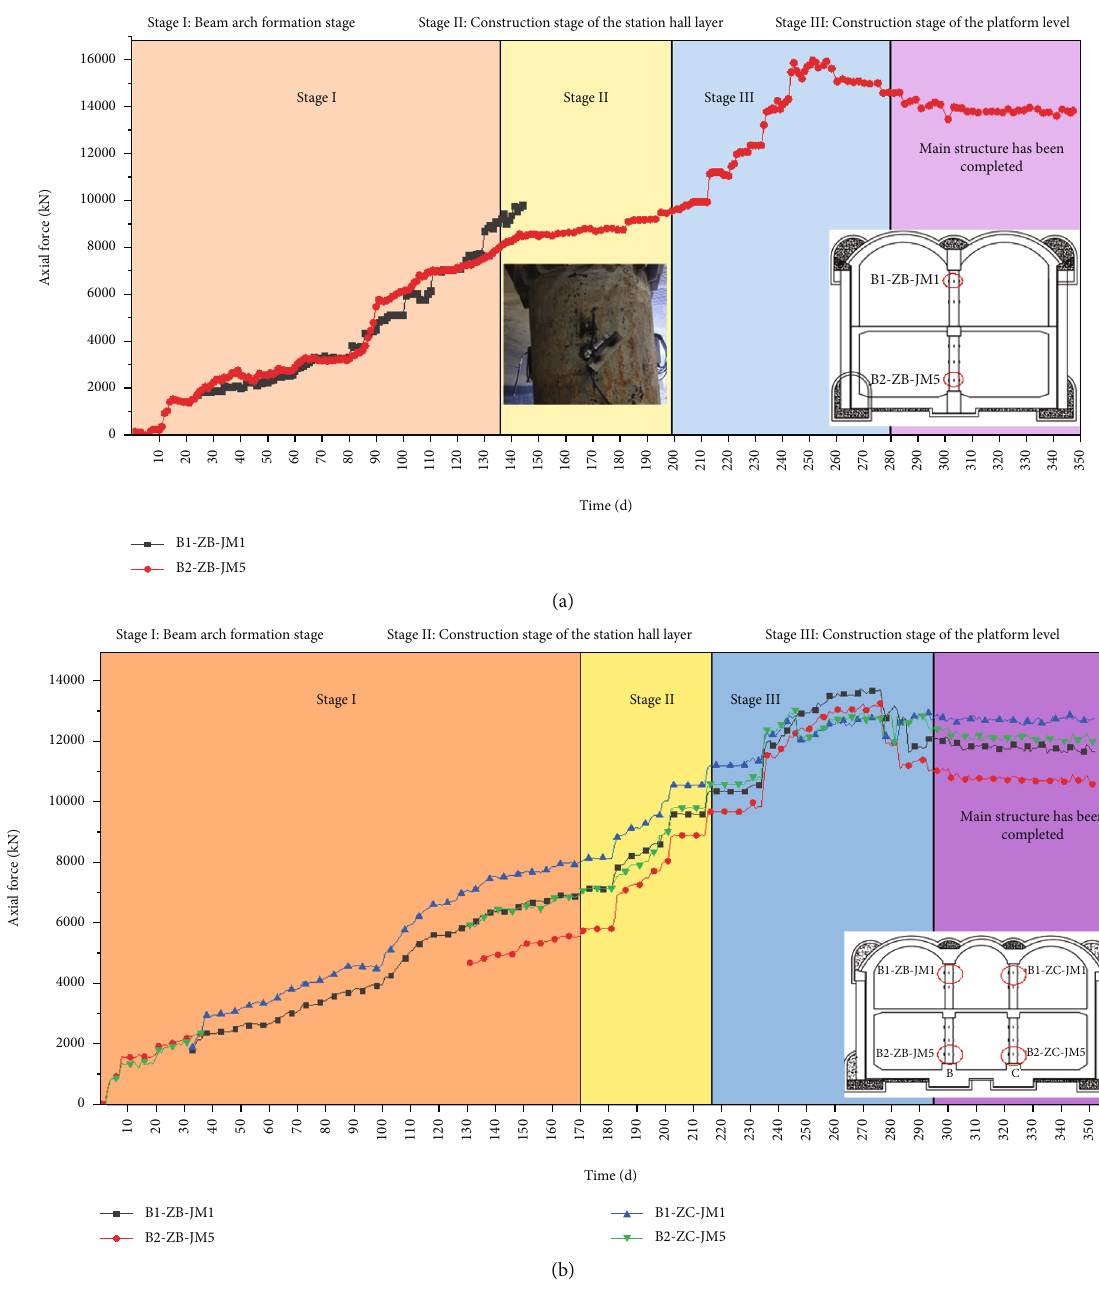
Figure 3: Axial force change in the central column during construction: (a) XHY station and (b) SLH